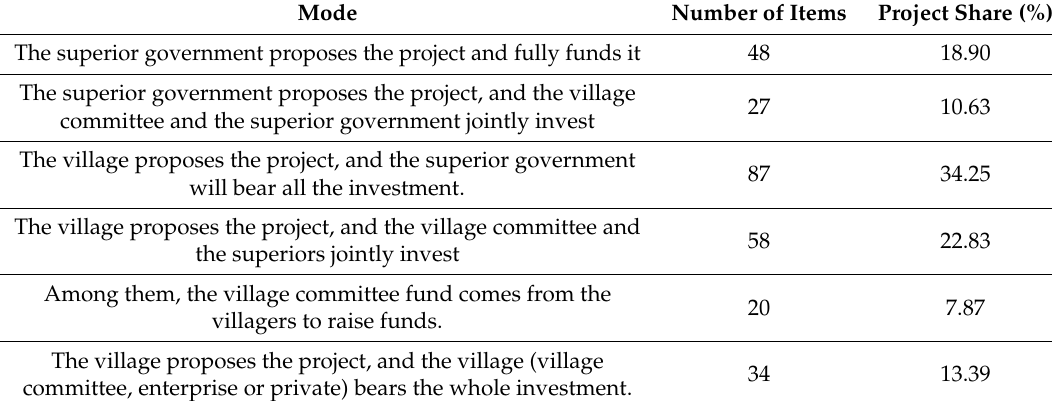
Table 4. Classification and proportion of agricultural infrastructure construction models.